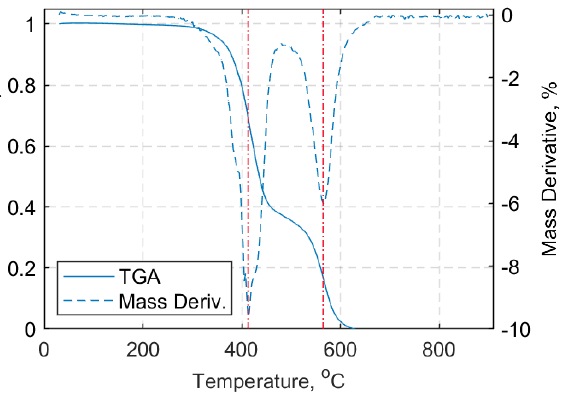
Figure 6. Left : Normalized mass loss curve vs. temperature (°C). Right : Mass derivative curve (%) vs. temperature (°C); air atmosphere for neat epoxy resin. Table 2. Volume fractions of matrix and fiber (%) & composite density (g/cm 3 ).